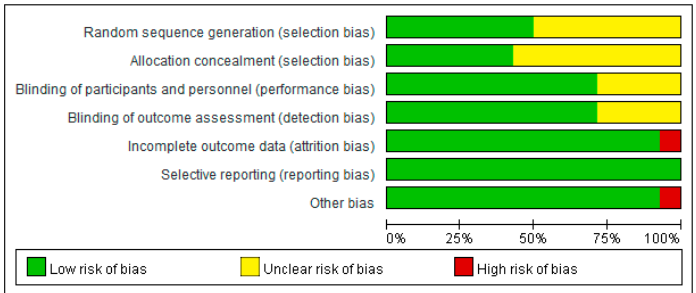
Figure 2. Summary of risk of bias for all the included articles.